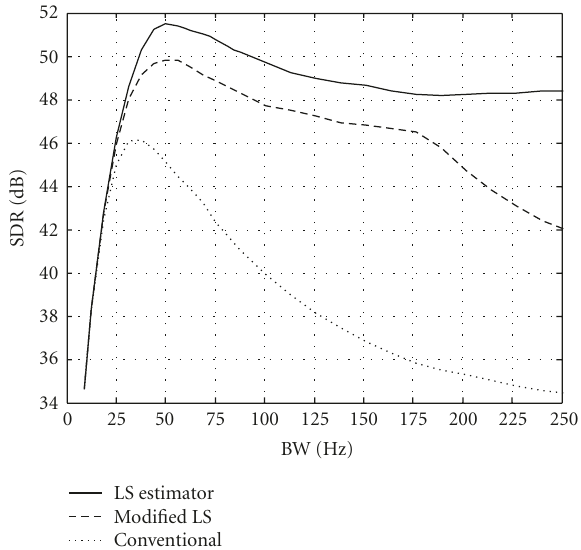
Figure 11: SDR obtained with the modified LS estimator for several numbers of notch